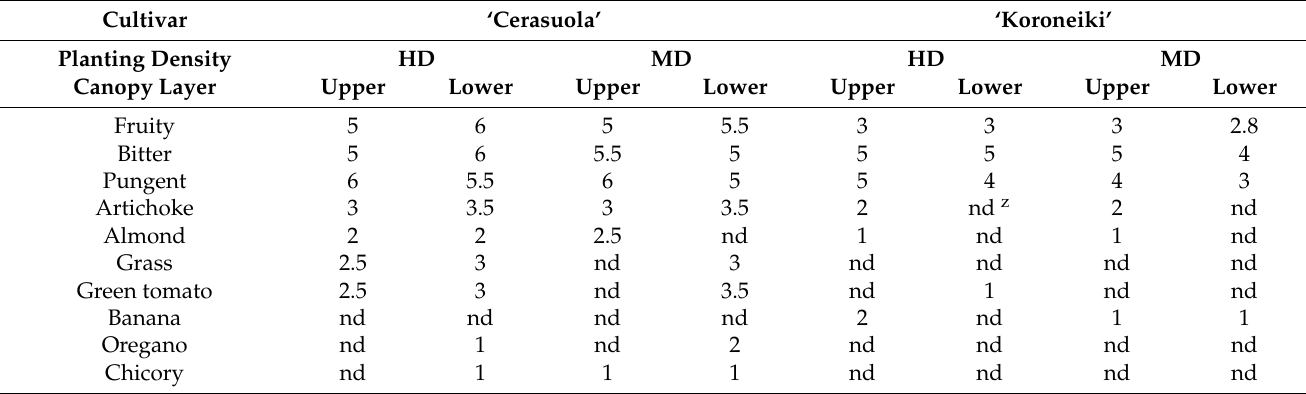
Table 4. Quantitative descriptive profile for sensory evaluation of ‘Cerasuola’ and ‘Koroneiki’ oils obtained from two planting densities and two fruit canopy positions. Numbers represent the median of the attributes ( n = 8) according to the international olive oil council (COI/T.20/DOC.15/Rev.10) standards. Cultivar ‘Cerasuola’